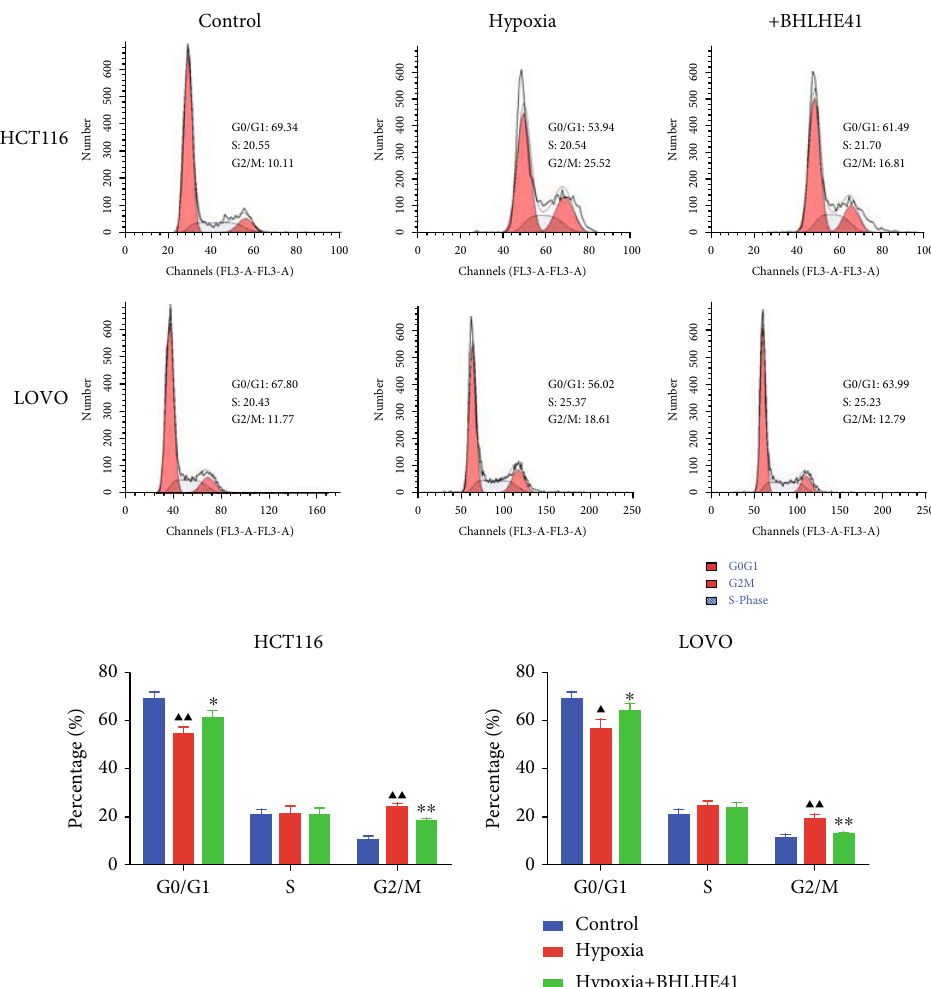
Figure 5: BHLHE41 overexpression blocked the HCT116 and Lovo cell cycle, and decreased the number of cells in G2/M phase. The cell cycle in hypoxia-induced CC cells was tested by fl ow cytometry. All experiments have been performed in triplicate and data were expressed as mean ± SD. ∗∗ P < 0 : 01 vs. hypoxia; ▲▲ P < 0.01 vs.